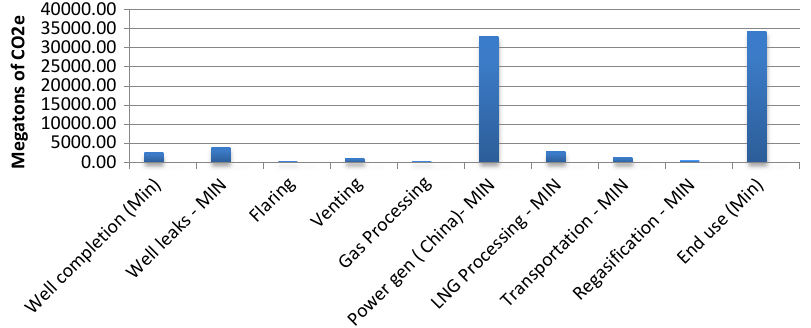
Fig. 3. Emission from each development stages in an export scenario for 280 TCF of